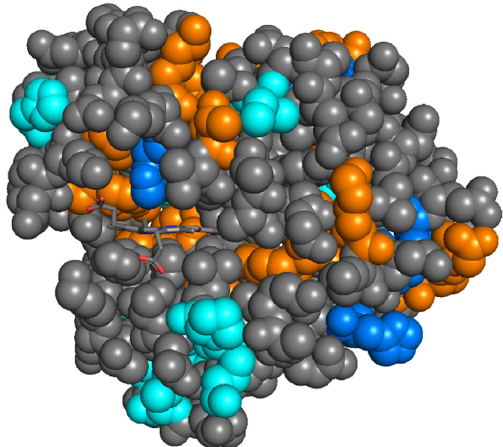
Figure 3. Crystal structure of holo ‐ myoglobin (Protein Data Bank accession code 1YMB), with important residues for oxidative footprinting highlighted. Residues that were oxidised in our work that were previously identified as oxidation ‐ sensitive in the FPOP literature are coloured blue. New modifications identified in our work (mostly near the haem group) are coloured orange. Modification sites that were identified in the FPOP literature but not in our experiments are coloured cyan.